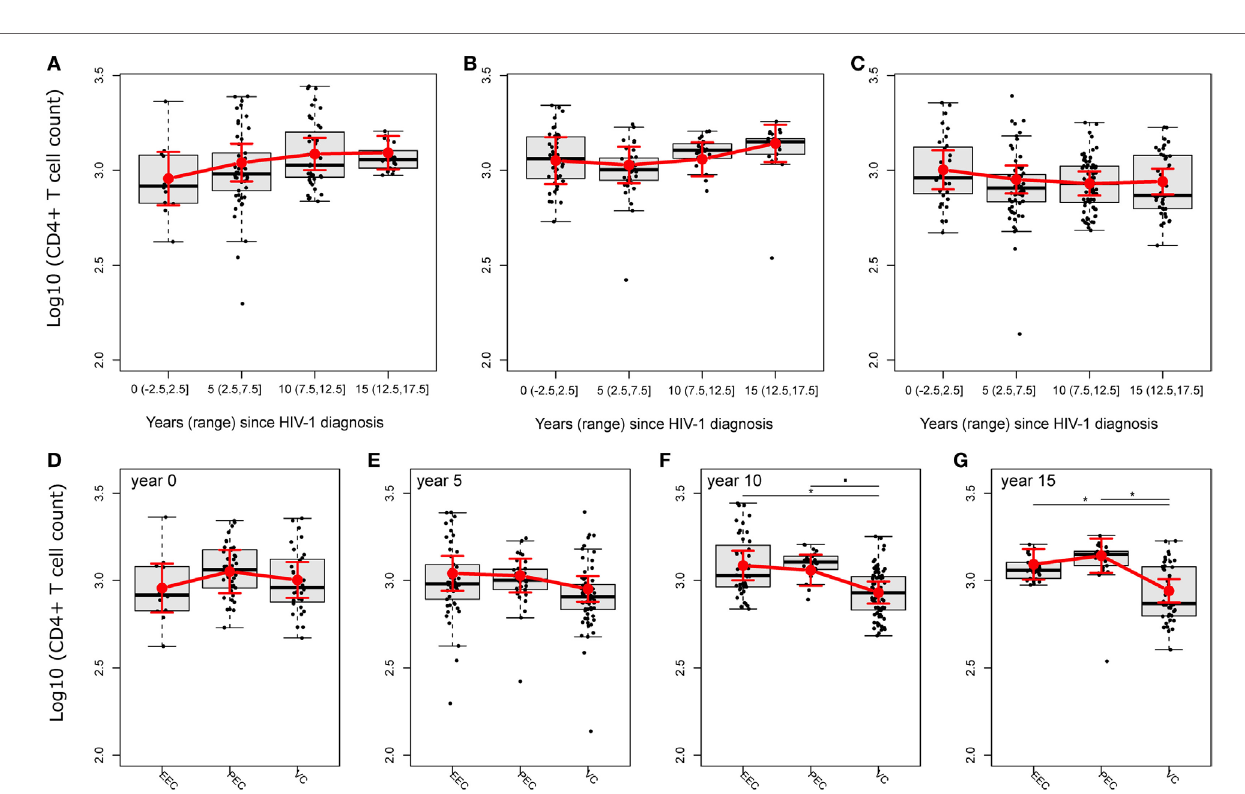
FigUre 3 | HIV controllers (HICs) have no evidence of CD4 + T cell decline. Fitted (sample) instant in/decrement of log 10 -transformed CD4 + T cell counts at 5-year intervals (ranges) after HIV-1 diagnosis for HICs, ebbing elite controller (a) , persistent elite controller (B) , and viremic controller (c) , and the comparison of fitted mean log 10 -transformed CD4 + T cell counts among HICs at year 0 (D) , 5 (e) , 10 (F) , and 15 (g) after HIV-1 diagnosis. Analysis was performed by selecting the best nested linear mixed-effect models fitted by maximum likelihood. Deviance analysis was performed among nested models by F -test with Kenward–Roger approximation. Slopes/contrasts were obtained from the best fitted models to compare CD4 + T cell counts kinetic estimated means and CI 95% (red dots and vertical bars) among HIC groups of individuals. Degrees of freedom for estimated effects were approximated by the Satterthwaite method. Boxplots represent the IQR and sample median (central solid black line). Red dots and vertical bars represent linear model estimated adjusted means and 95% confidence intervals (CI 95%). Again, P -values were corrected by the Tukey Honest Significant Difference. ▪ P < 0.1, * P <